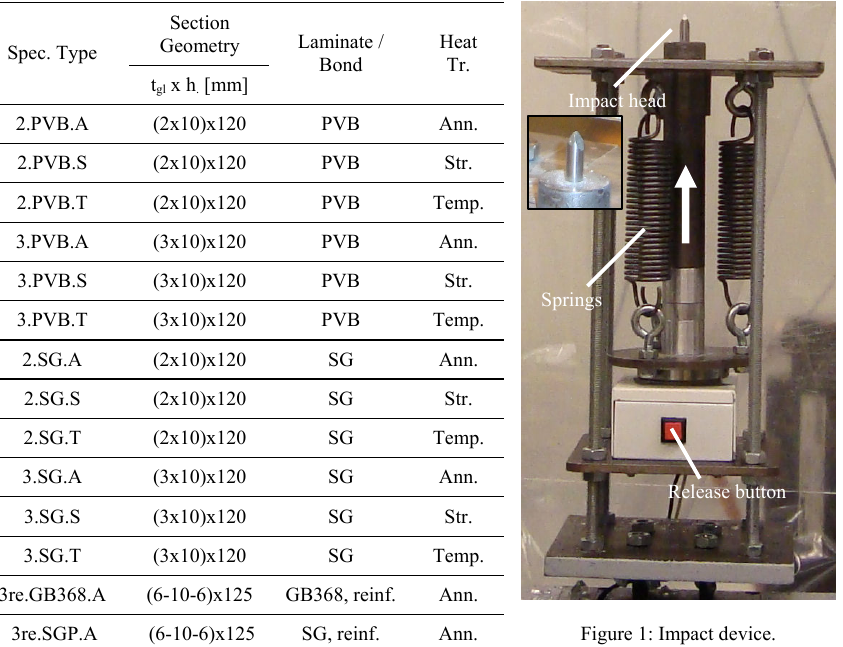
Figure 1: Impact